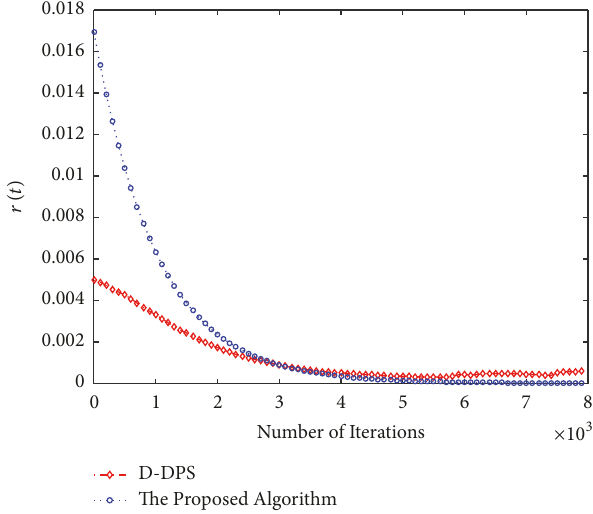
Figure 3: Comparison of D-DPS and the proposed